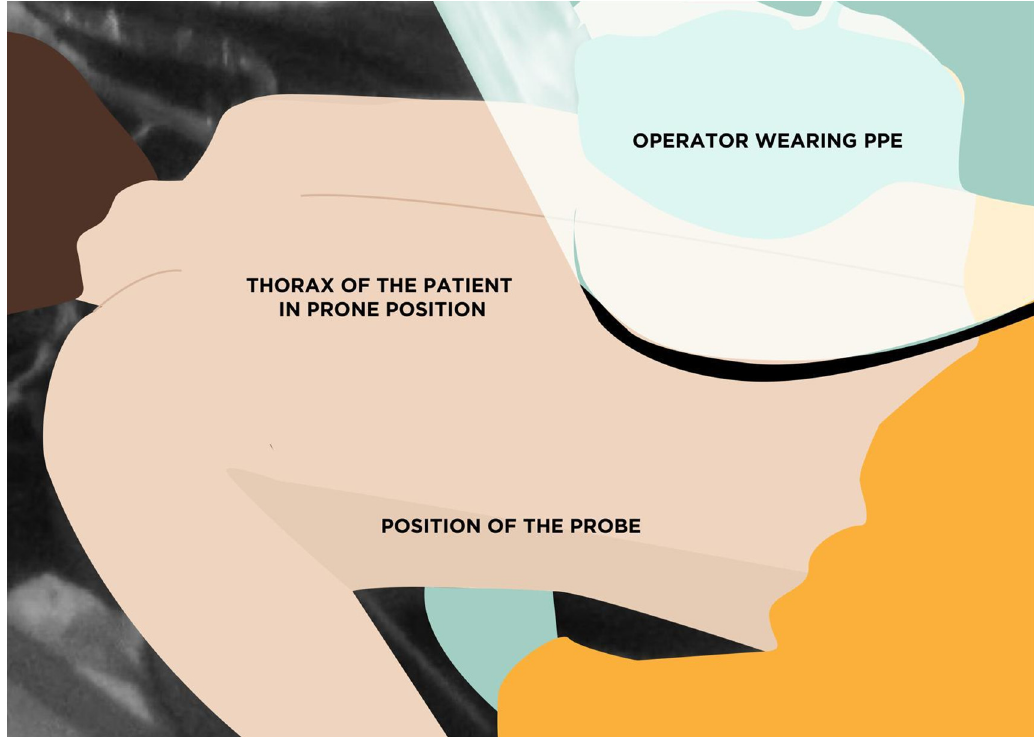
Figure 1. Relative positions of the operator performing echocardiography and the patient in prone position. Abbreviations: PPE, personal protective equipment. Reprinted with permission from [8].